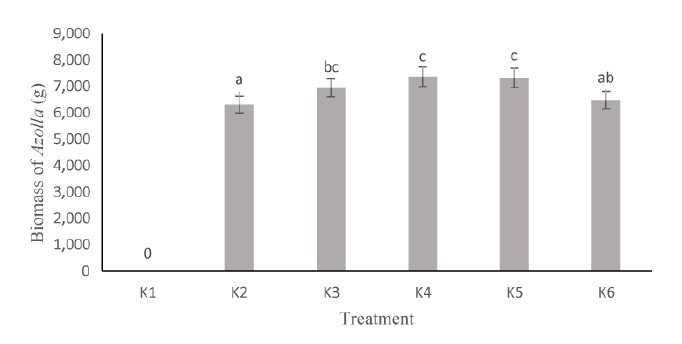
Figure 5 Azolla biomass at 30 days after planting. Bars (means (cid:6) standard deviation; n = 3) with different letters are significantly different at LSD 0.05.